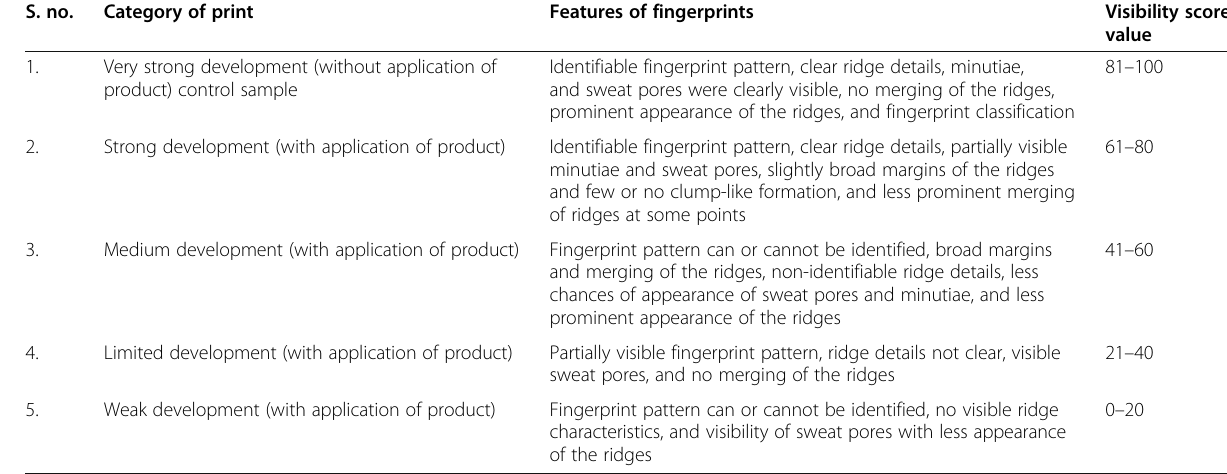
Table 1 Standard categories used for differentiation of fingerprints after applying products (Sears et al. 2012; Almog et al. 2014) S. no.